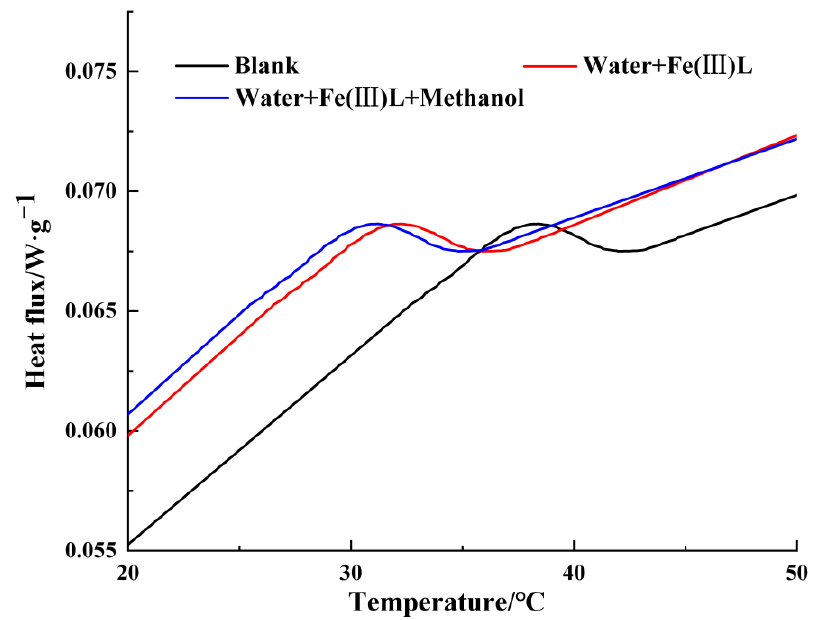
Figure 8. DSC of oil samples with and without Fe( III )L and methanol.